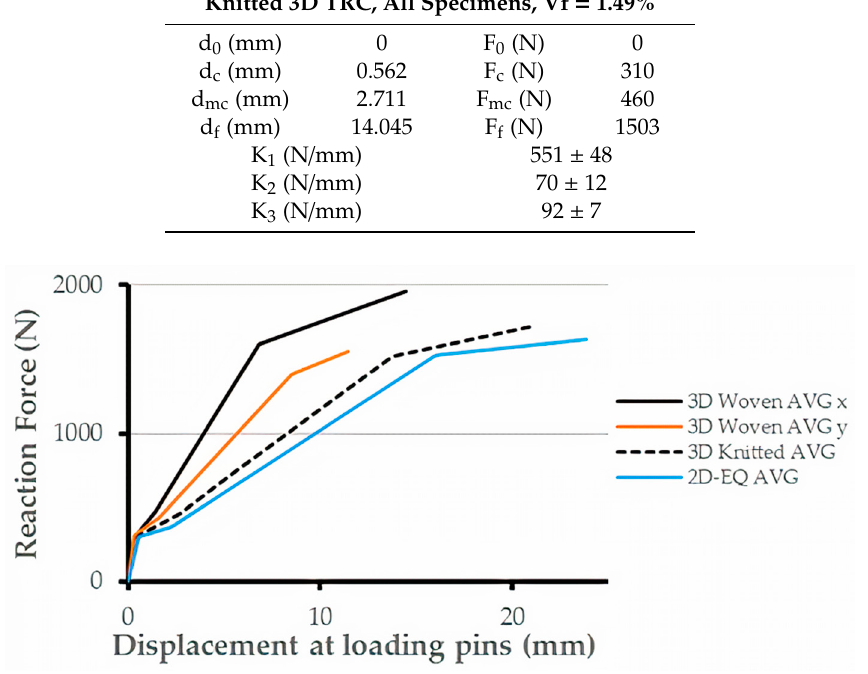
Along y: Figure 13. All flexural experimental curves in x- and y-direction for the knitted 3D TRC layup, as well as averaged curve. Table 6. Averaged flexural experimental parameters for the knitted 3D TRC layup. Knitted 3D TRC, all specimens, Vf = 1.49%